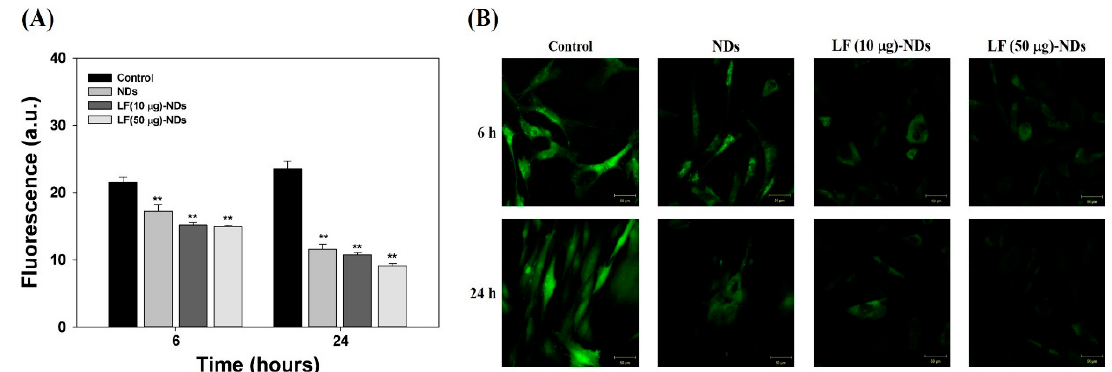
Figure 5. ( A ) Quantitative intracellular ROS levels of MC3T3-E1 cells treated with extract from NDs, LF (10 μ g)-NDs and LF (50 μ g)-NDs for 6 and 24 h after the cells were treated with 300 μ M H 2 O 2 for 30 min. The error bars represent mean ± standard deviation ( n = 4). p value is a comparison between LF-conjugated NDs and NDs. ** p < 0.01; ( B ) Fluorescence images of intracellular levels of MC3T3-E1 cells treated with extract from NDs, LF (10 μ g)-NDs and LF (50 μ g)-NDs for 6 and 24 h after the cells were treated with 300 μ M H 2 O 2 for 30 min. After 6 and 24 h treatment, the cells were stained with 2 ′ ,7-dichlorodihydrofluorescein diacetate (DCFDA) and observed by a confocal laser scanning microscope (CLSM). Scale bar = 50 μ m.